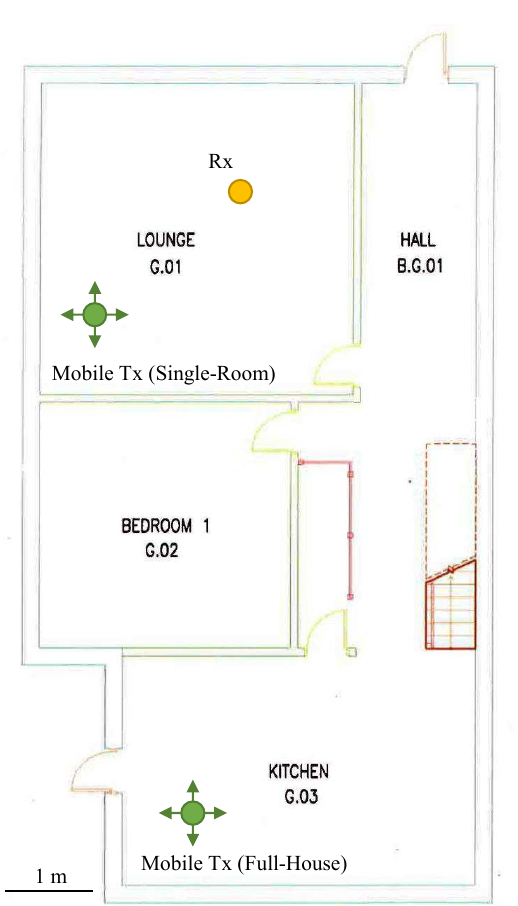
Figure 6. Mobility is evaluated in a real residential